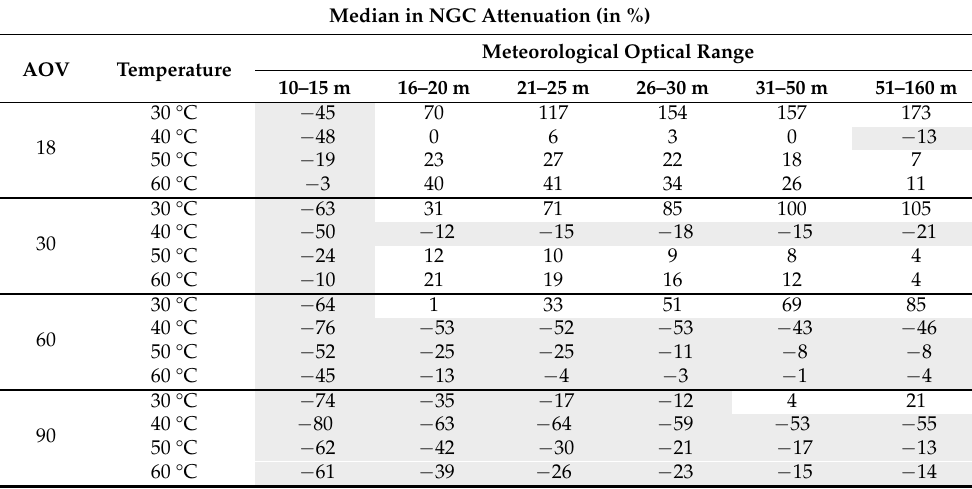
Table 2. NGC attenuation (in %) with respect to MOR, AOV, and temperature.